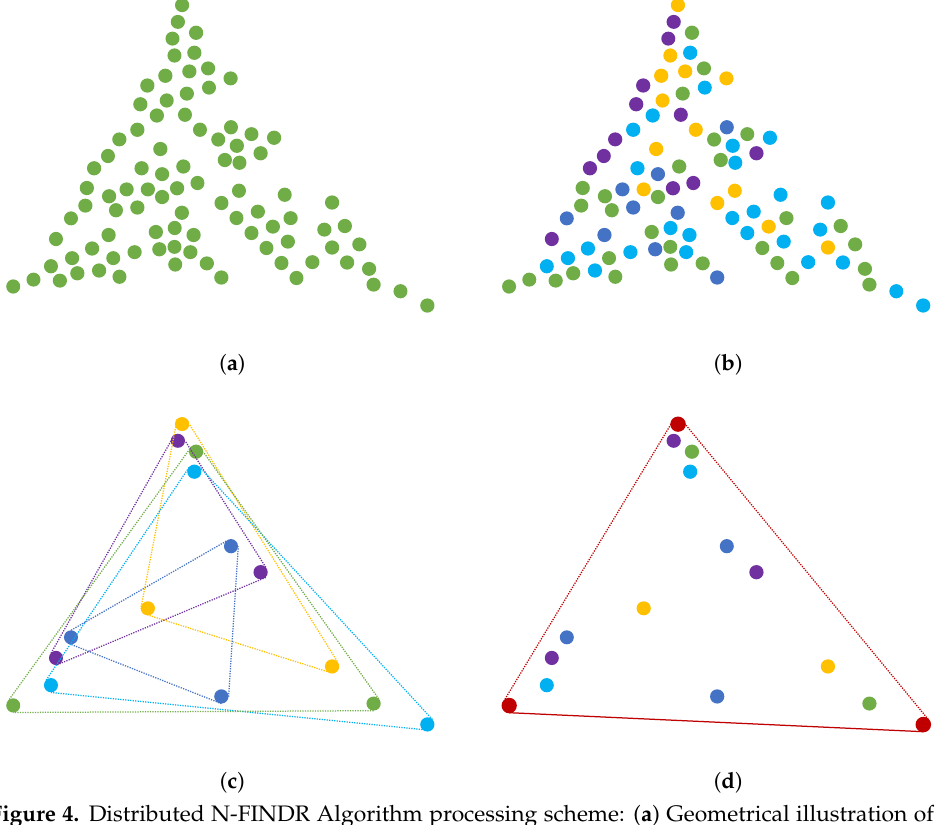
Figure 4. Distributed N-FINDR Algorithm processing scheme: ( a ) Geometrical illustration of the dataset for p = 3 endmembers, ( b ) Random partitioning of the dataset, ( c ) Simplexes found at each processing node, ( d ) Promising endmembers processed at the master